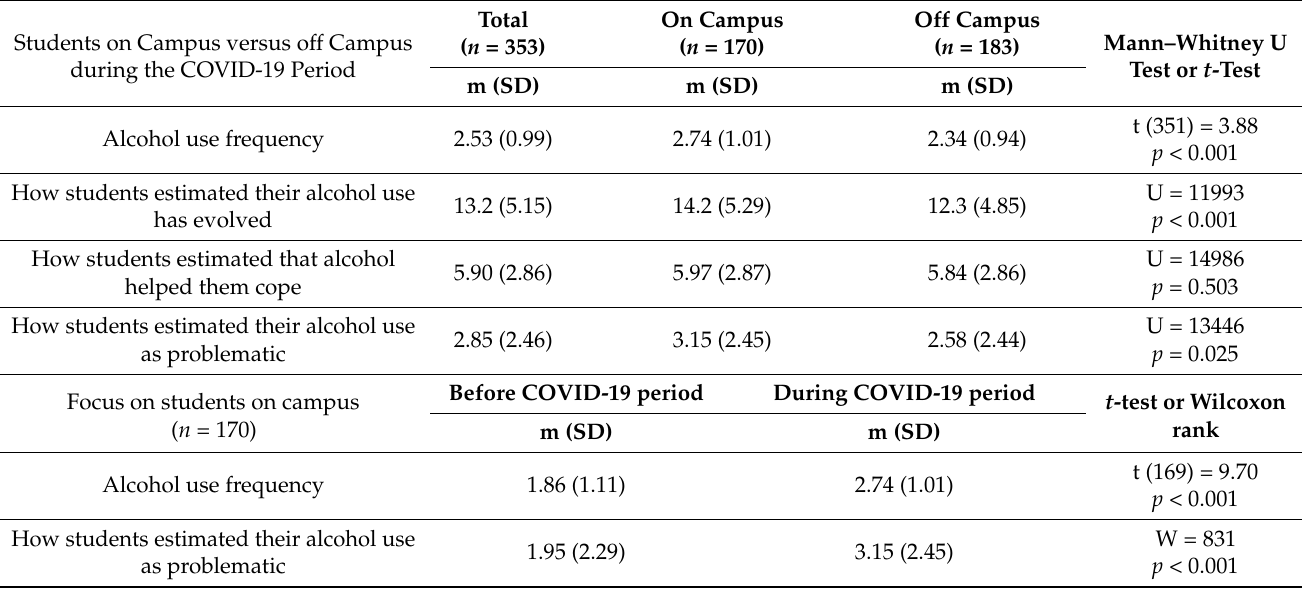
Table 2. Alcohol consumption before and during the COVID-19 period, depending on residential status ( n =